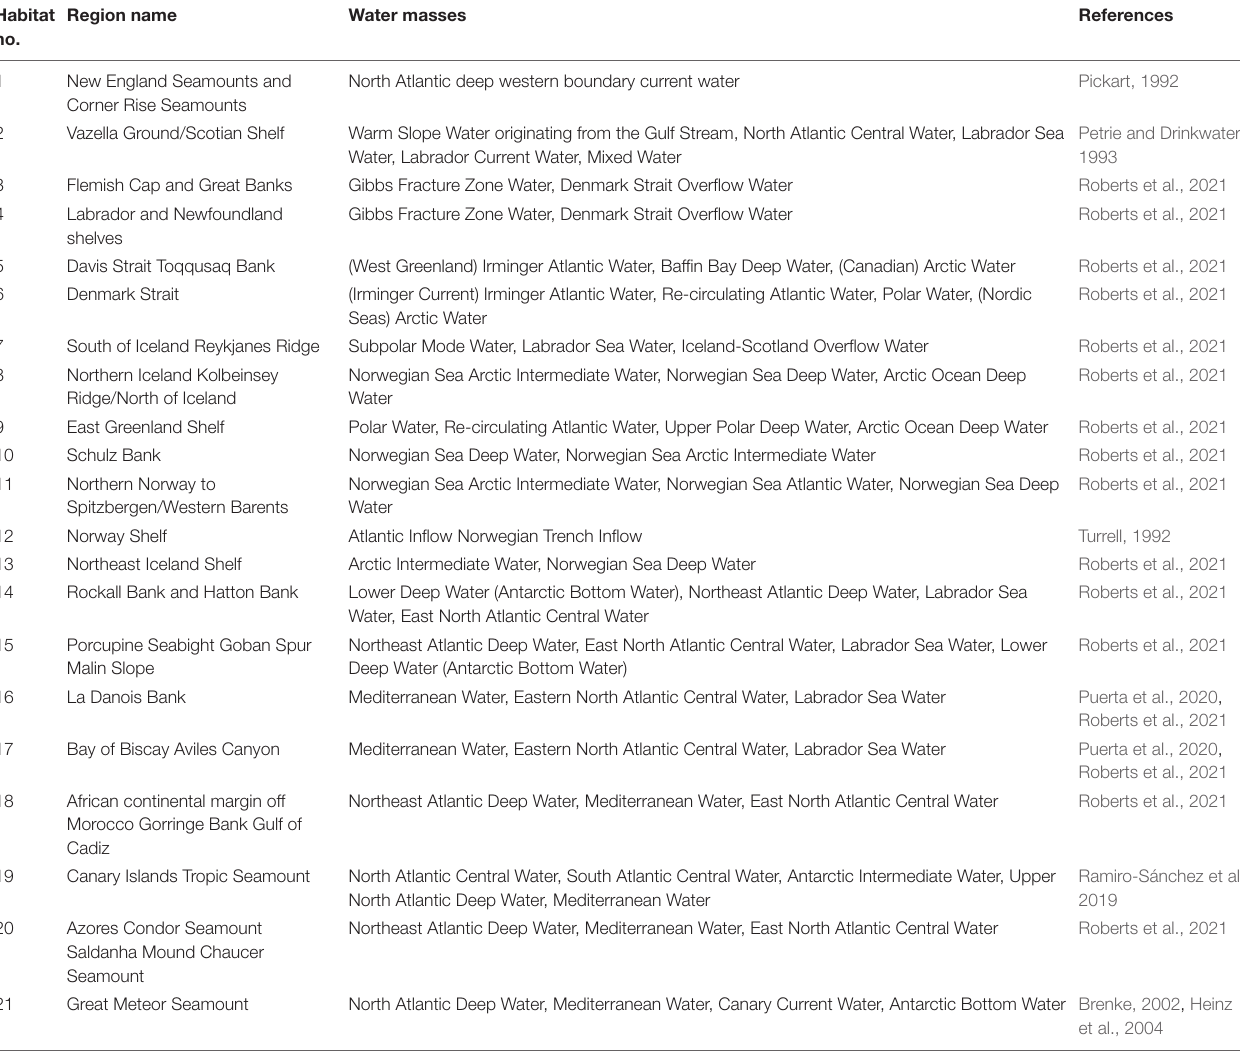
TABLE 2 | The habitat number given in our study, the corresponding name, the associated water masses and related references. Habitat